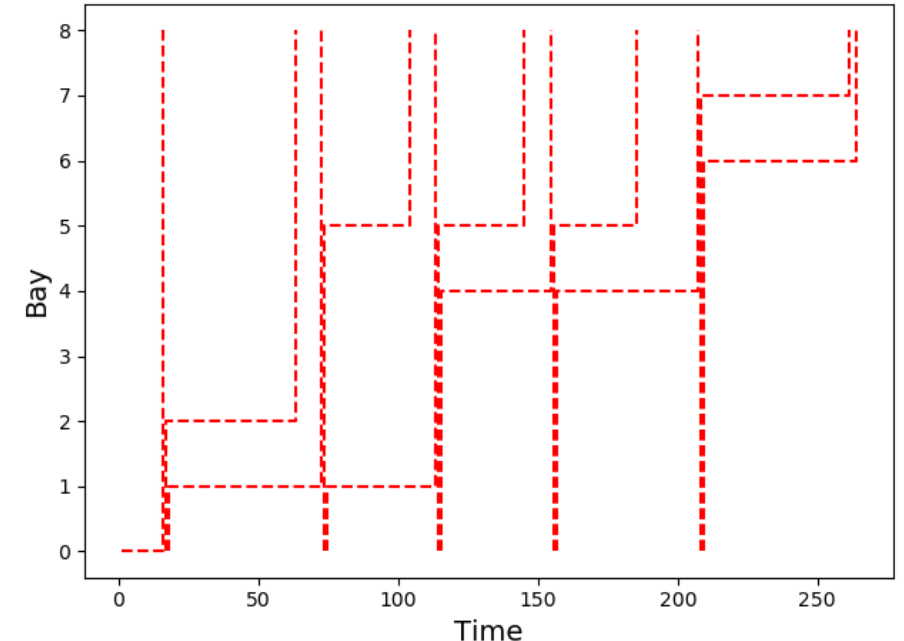
Figure A2. Numerical experiment: ET time–space diagram.